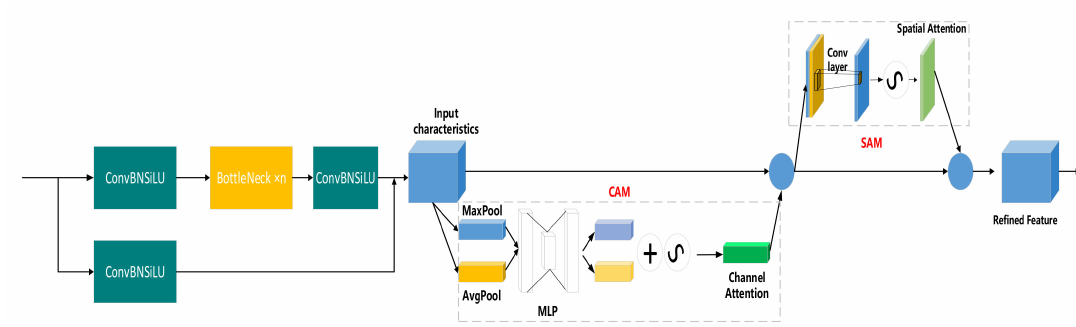
Figure 3. Structure of CBAM.